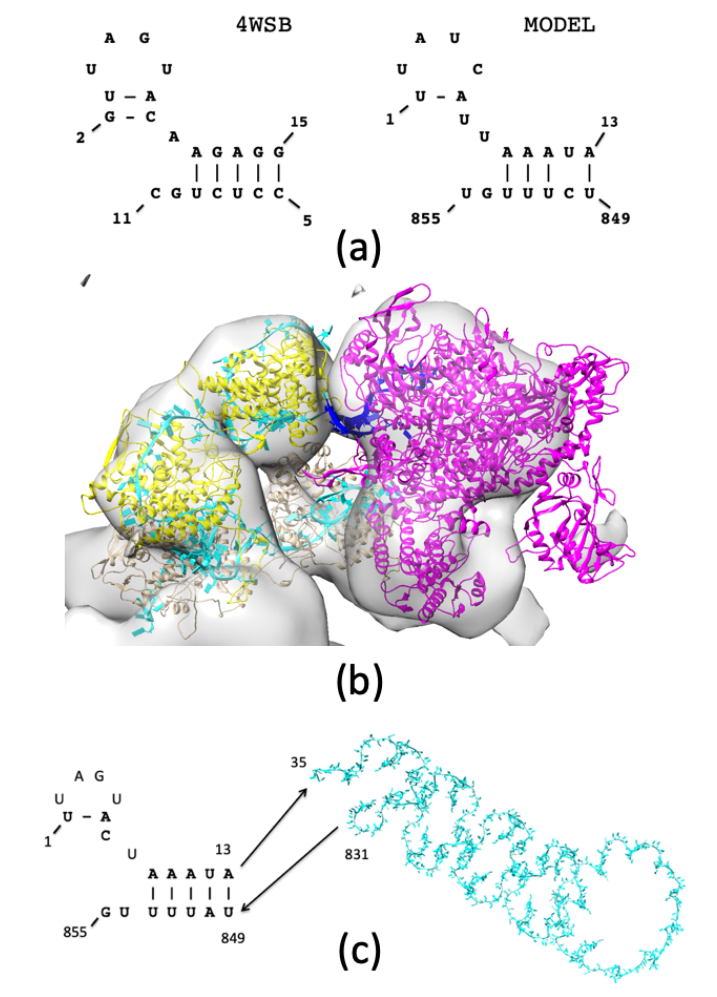
Figure 5. Modeling POL within the RNP complex. ( a ) The “half-corkscrew” secondary structure of vRNA (PDB accession code: 4WSB) is used to model POL-binding at the 3 (cid:48) and 5 (cid:48) termini. ( b ) Docking POL into the cryo-EM density map shows the vRNA promoter structure (blue) occupies the space between the NP—vRNA complex (yellow and cyan, respectively) and POL (magenta). A test of the goodness-of-fit for POL identifies 78.4% of the heavy atoms are retained within the outer contour of the EM density map of emd_2208 [16]. ( c ) Both ends of the vRNA in the “half-corkscrew” arrangement are joined with the rest of the vRNA at the residues